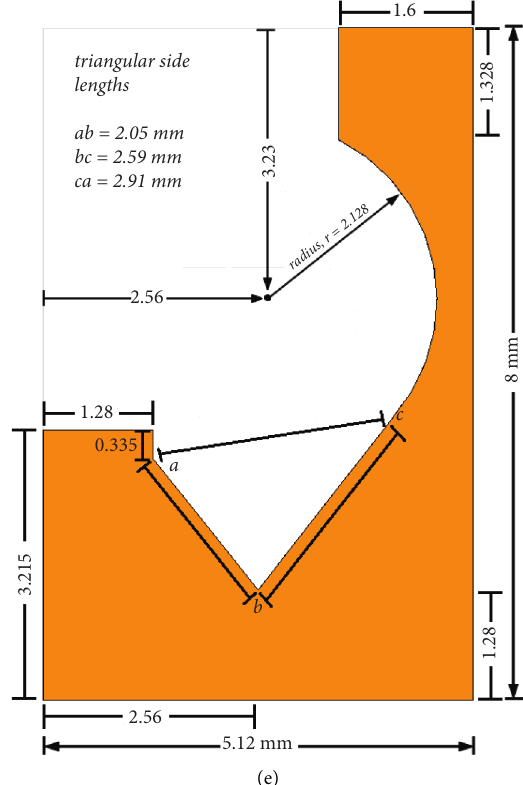
Figure 1: Antenna design and parameters (a) 3D view, (b) front view, (c) back view, (d) front view with dimensions, and (e) back view with